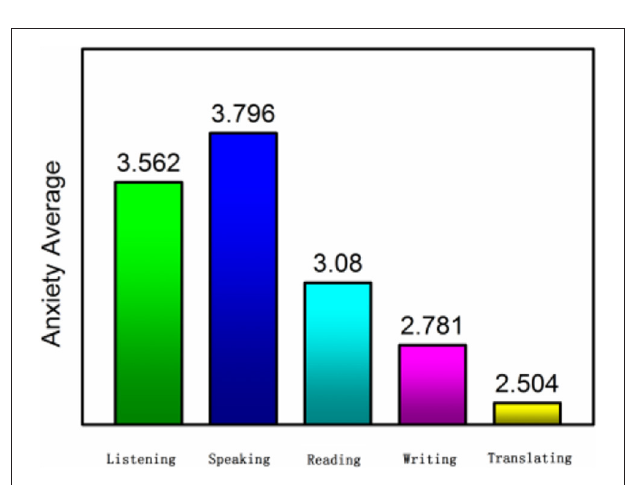
FIGURE 4 | The average value of students’ anxiety in language skills.